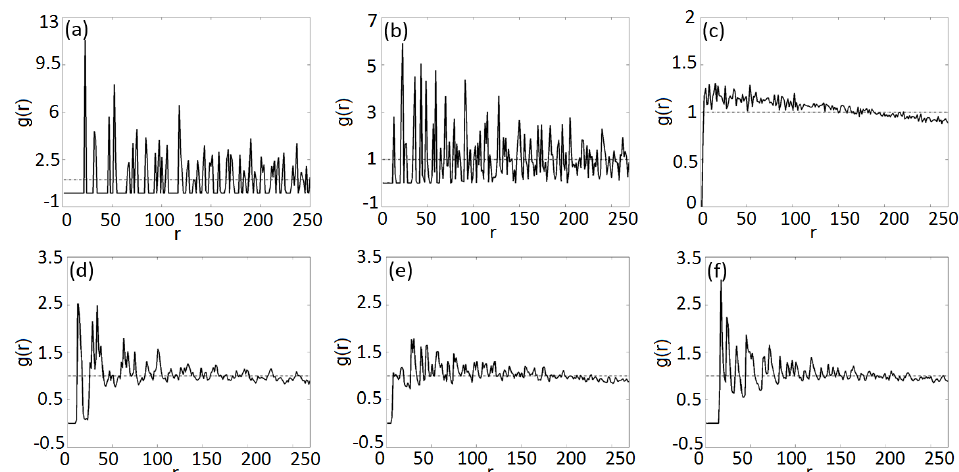
Figure 3. The radial distribution functions (RDFs), g ( r ) of point patterns, for ( a ) N = 1024 square array; ( b ) N = 1108 Penrose array; ( c ) N = 1000 pseudo-random array; ( d ) N = 1000 µ -spiral array; ( e ) N = 1000 π -spiral array; and ( f ) N = 1000 τ -spiral array. The RDFs are calculated using the ImageJ software package, and the horizontal axis is in units of pixels. The dashed horizontal line g ( r ) = 1 indicates the limit of an uncorrelated random gas